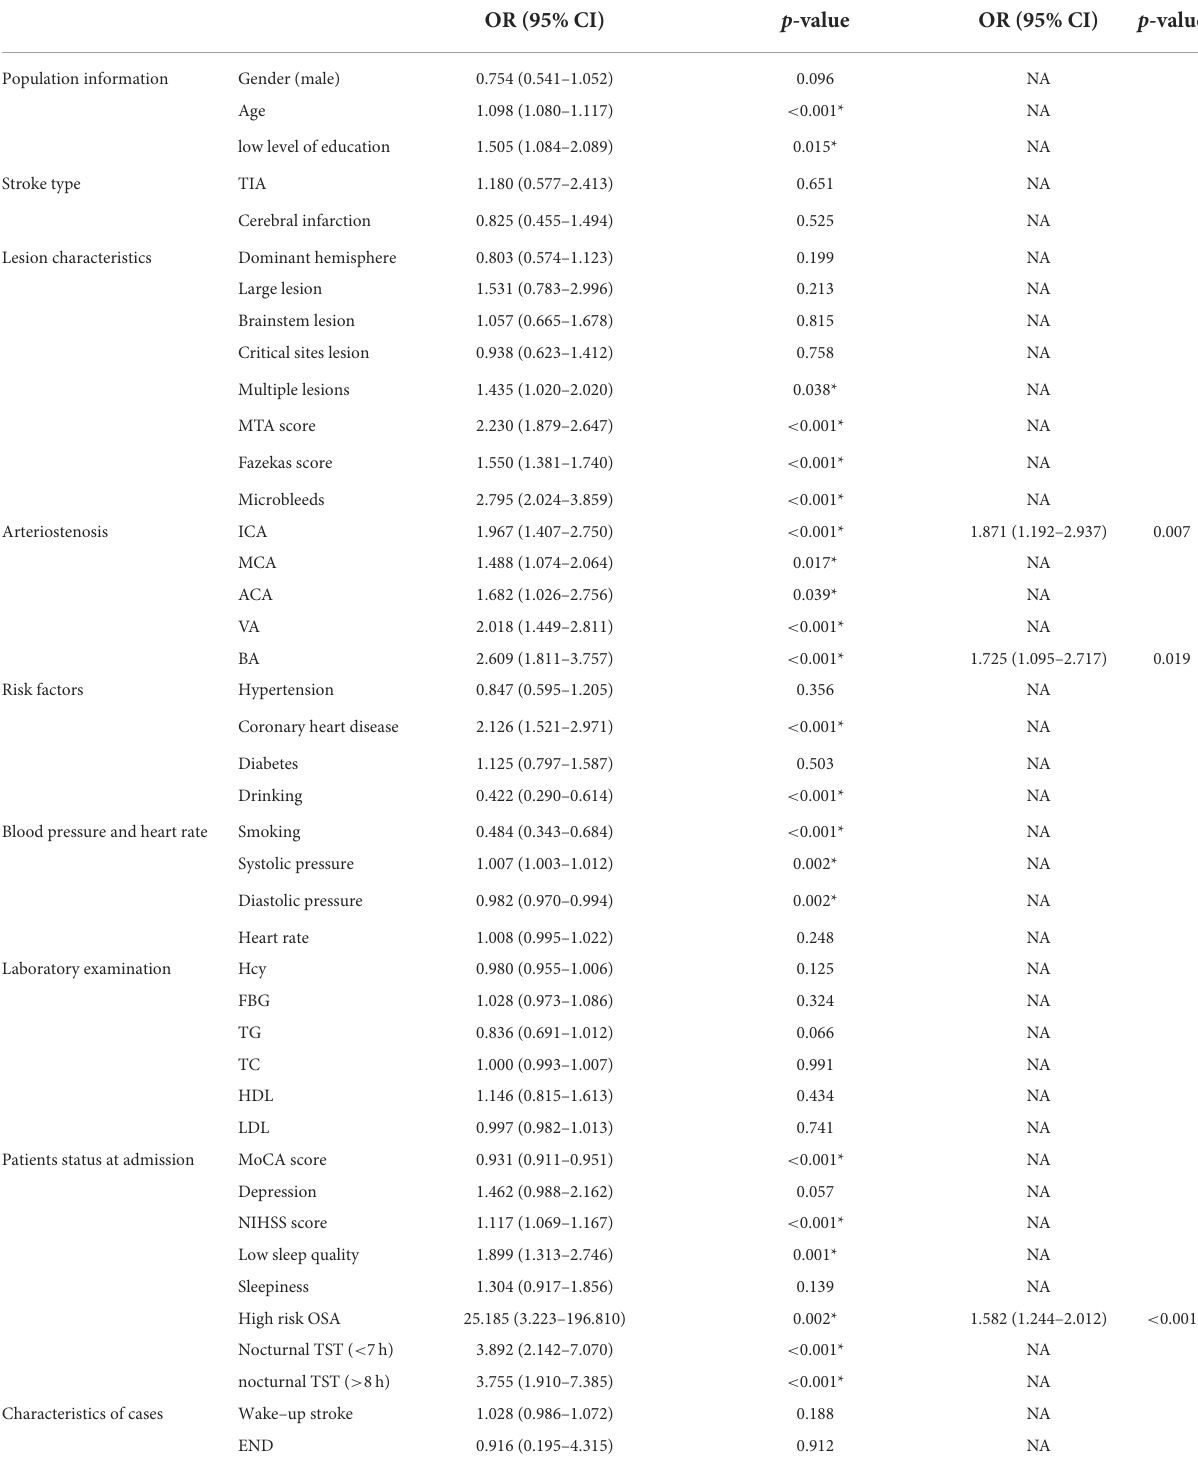
TABLE 6 Univariate and multivariate COX analysis of the influencing factors of all-cause death (survivors were coded 0, and dead patients were coded 1). Univariate COX analysis Multivariate COX